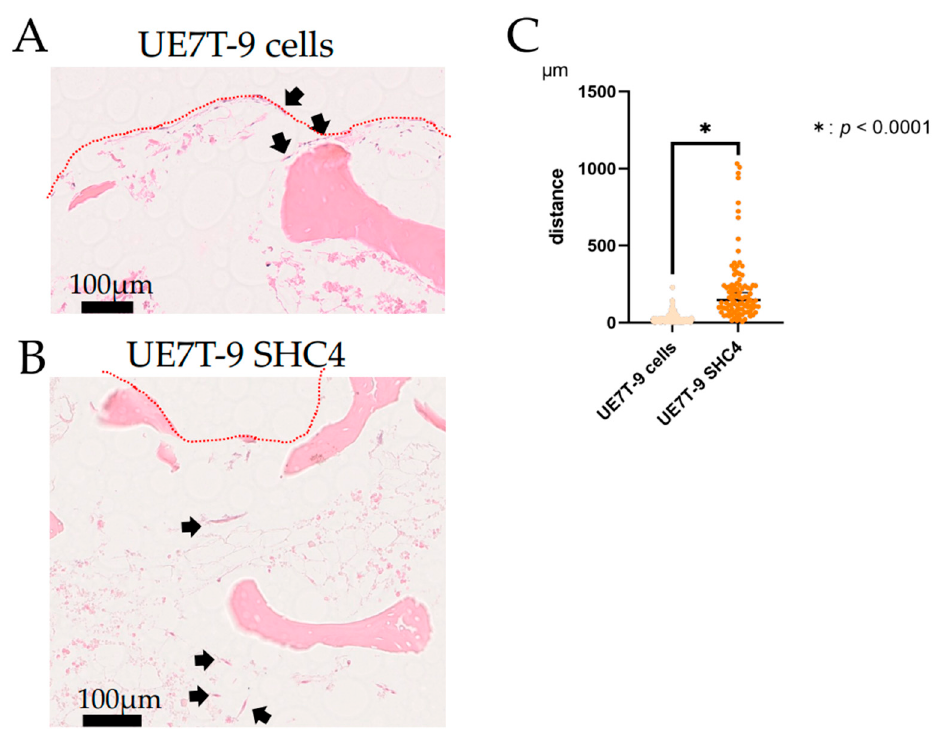
Figure 2. Infiltration into DCB. ( A ) HE-stained specimen of DCB, after 8-weeks of culture over UE7T-9 cells. UE7T-9 cells remained on the surface of the DCB. ( B ) HE-stained specimen of DCB after 8-weeks of culture of UE7T-9 SHC4. There were infiltrating cells around the bone trabecular (black arrow). ( C ) The infiltrating distance measured in UE7T-9 cells ( n = 117) and UE7T-9 SHC4 cells ( n = 96). The cells were randomly selected for distance measurement. Graph showing the distance that UE7T-9 cells infiltrated from the surface of DCB (red dot line). * indicates a significant difference of p < 0.0001 between the results of the two